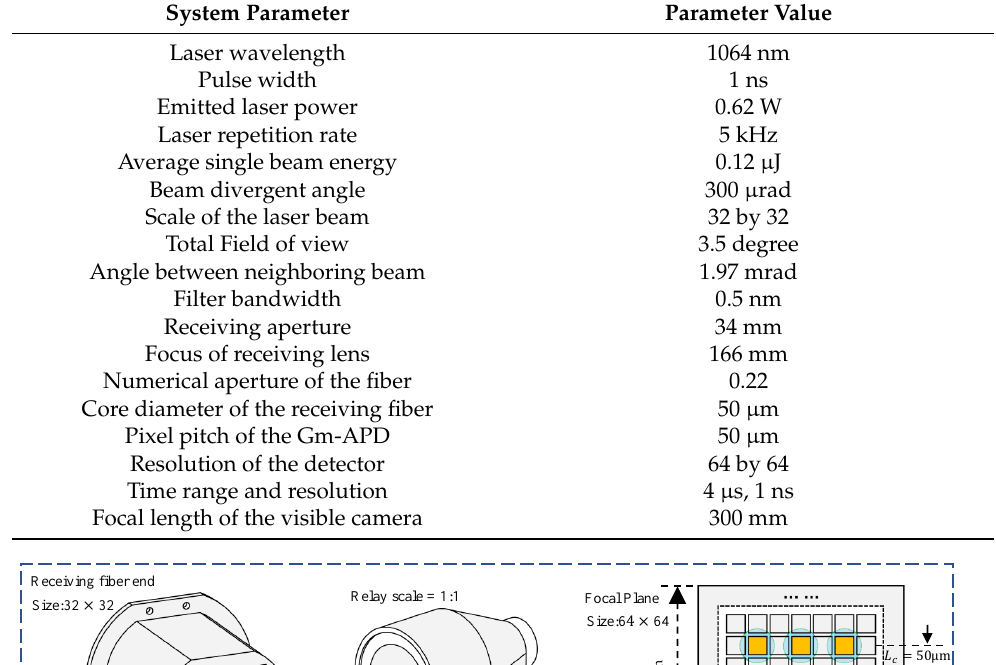
Table 1. Major specifications of the proposed LiDAR system.